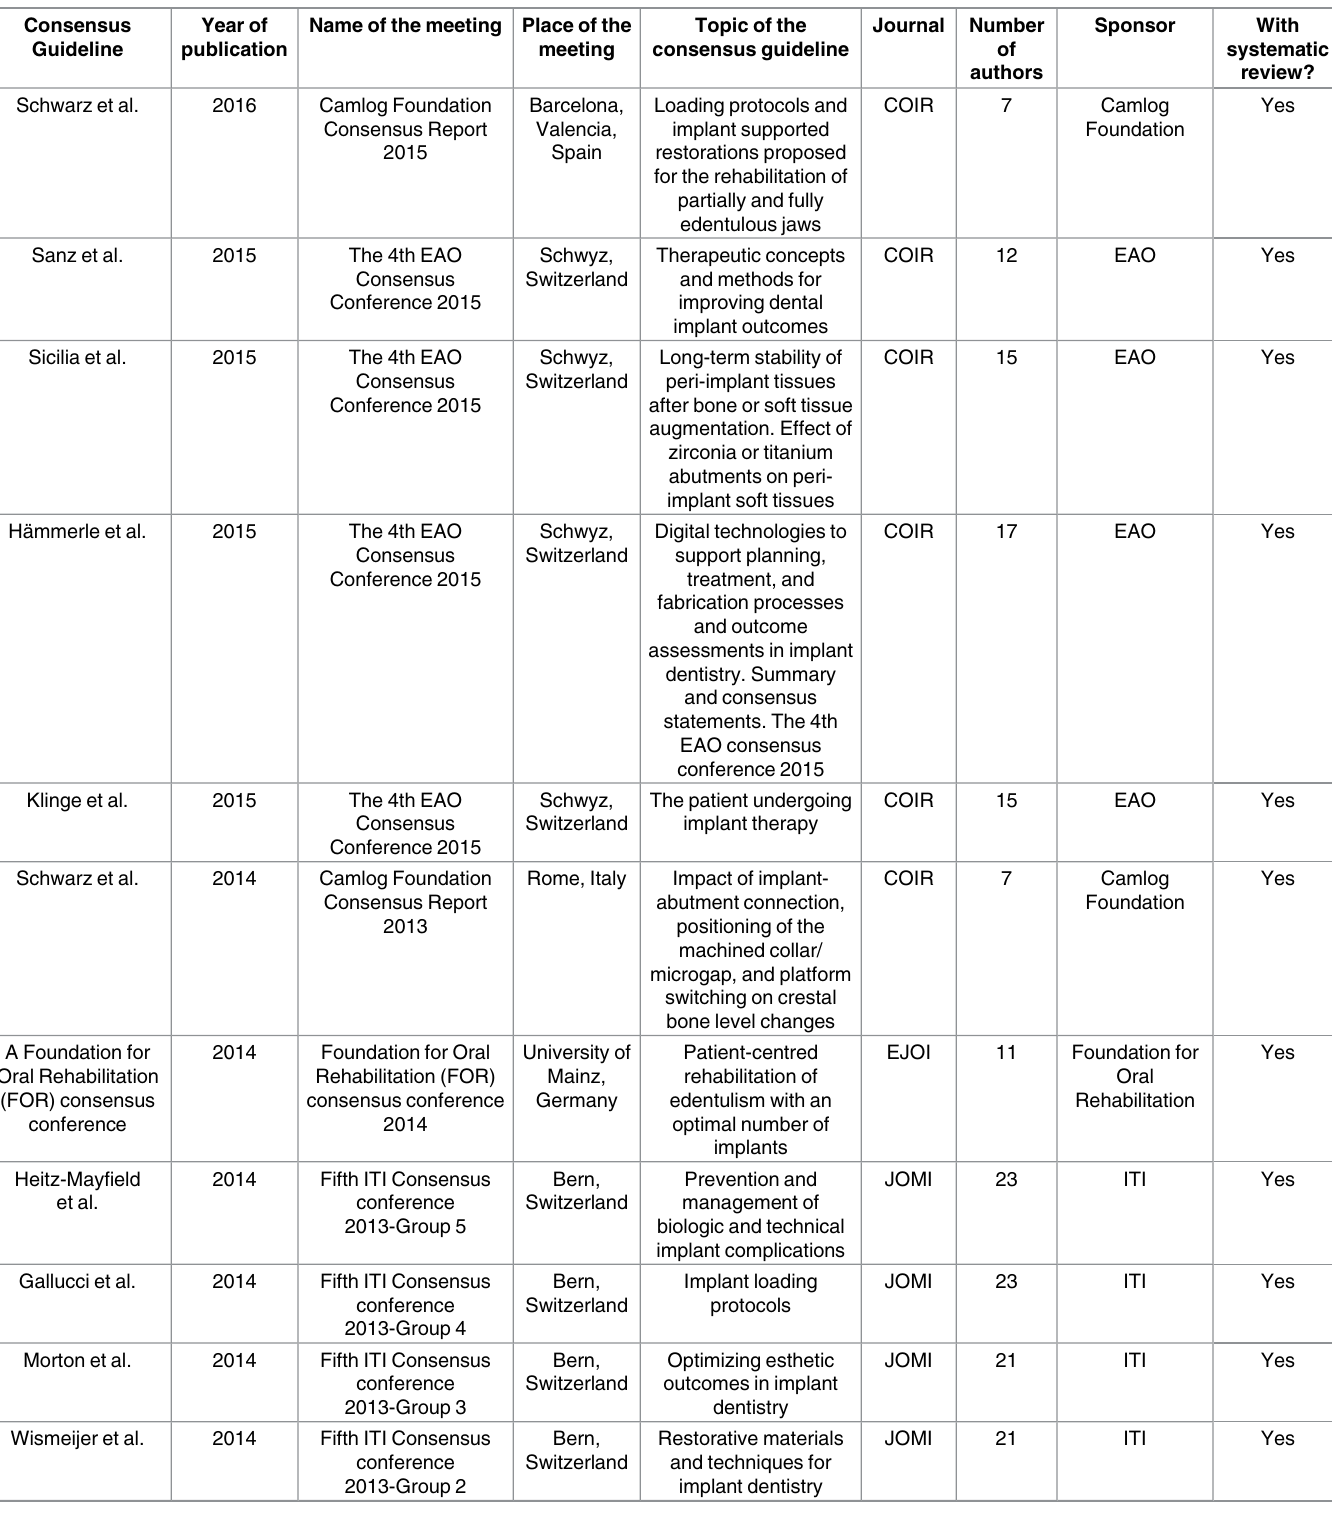
Table 2. Characteristics of the consensus guidelines included in this study. Consensus